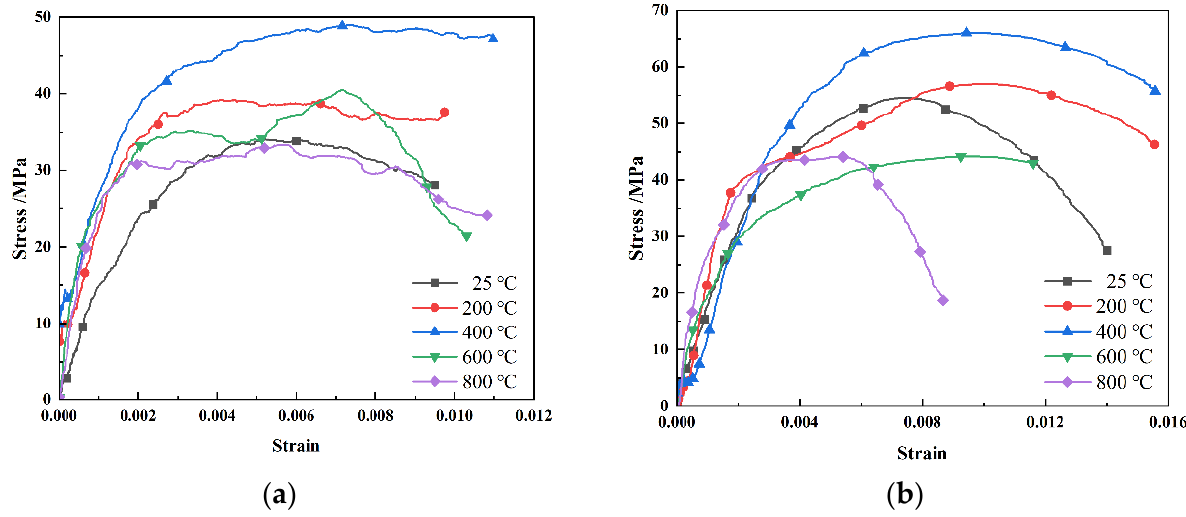
Figure 9. Dynamic stress–strain curve for a confining pressure of 1.5 MPa. ( a ) Impact velocity = 5.3 m/s; ( b ) impact velocity = 8.6